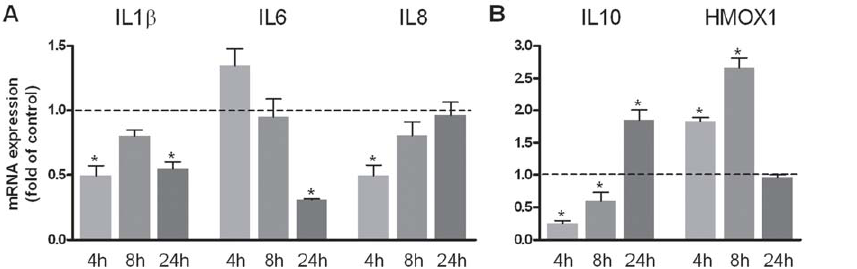
Figure 2. Effects of adiponectin on pro- and anti-inflammatory mediators. Effects of adiponectin (1 m g/ml) on IL1 b , IL6 and IL8 (A) as well as IL10 and HMOX1 (B) in oral epithelial cells at 4 h, 8 h, and 24 h. Mean 6 SEM; n=6; * p , 0.05 difference between adiponectin-treated and control cells.